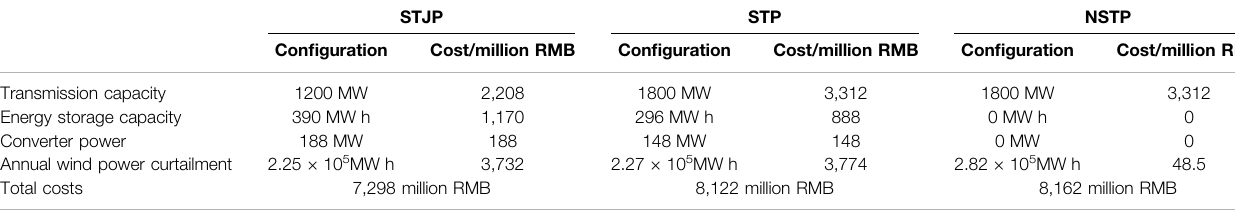
TABLE 3 | Comparison of planning schemes (engineering